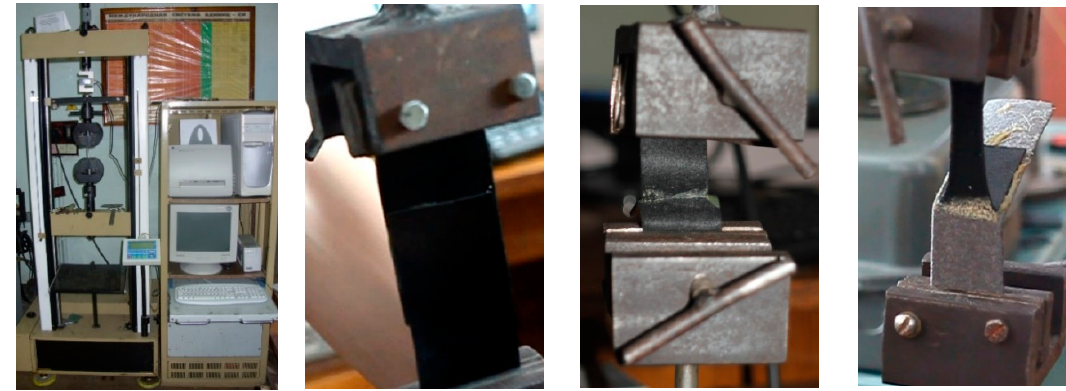
Figure 4. Polymer films on fabric tensile strength testing experimental set-up.